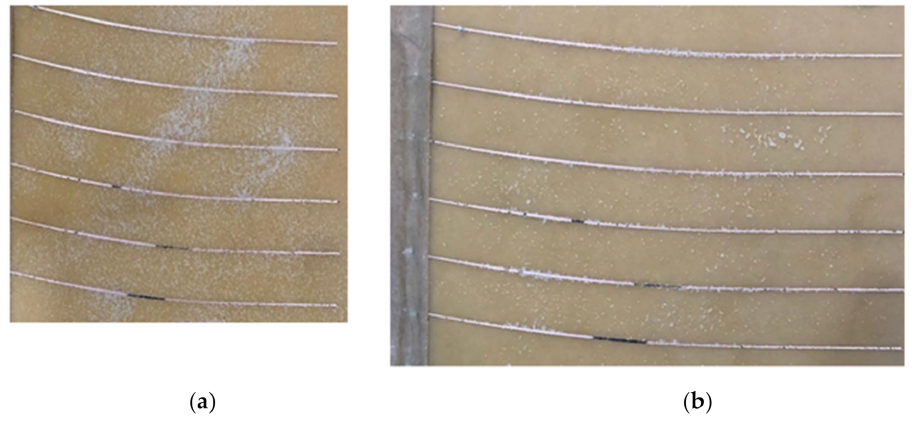
Figure 13. M2 model: ( a ) Before cleaning; ( b ) After